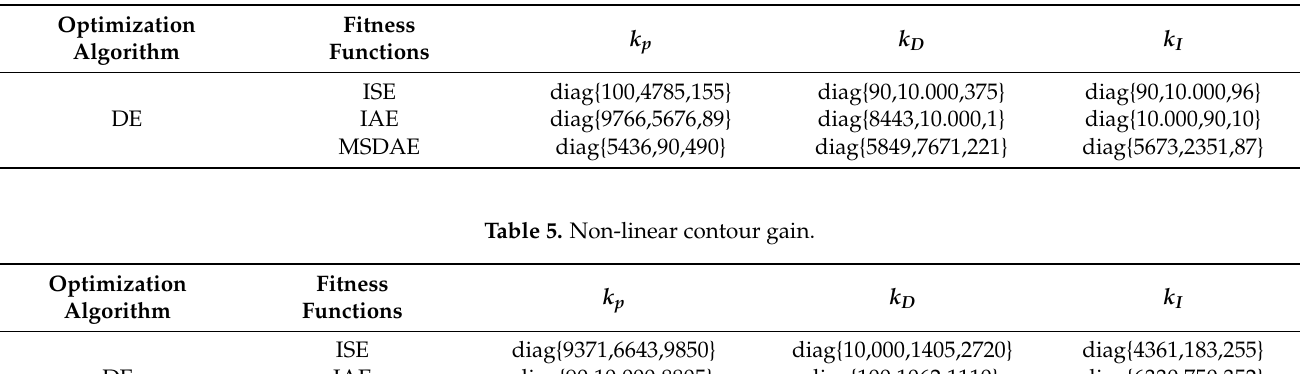
Table 4. Linear contour gain.